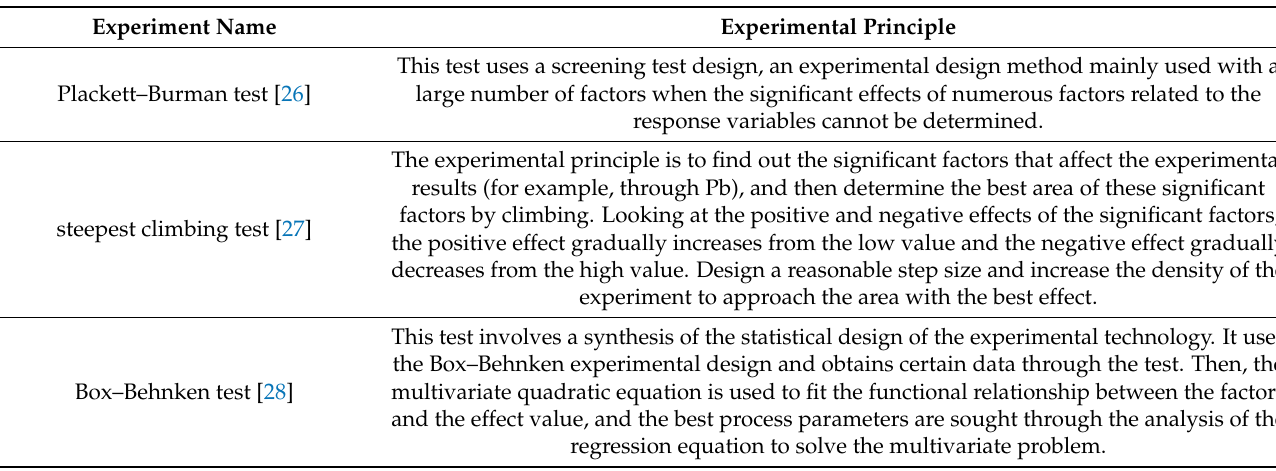
Table 1. Experimental